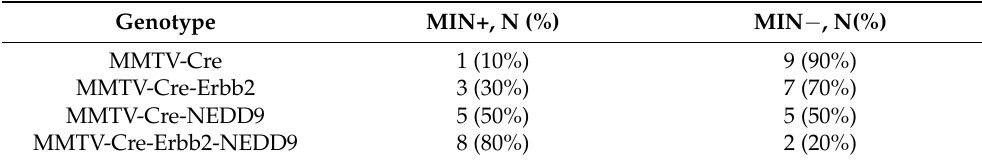
Figure 4. NEDD9 overexpression is associated with mammary intra-epithelia neoplasia. ( A ) Representative images of mouse mammary glands were stained with hematoxylin and eosin (H&E), genotypes as indicated in the figure. Scale bar — 20 mm; Insets — 200×. A total of 40 slides from 16-week-old nulliparous female mice with four genotypes were quantified. The average area per slide was 100–120 mm 2 . MIN was determined by lesions, characterized by glands, and lined by 1–2 layers of atypical epithelial cells with enlarged nuclei, clumped chromatin, variable nuclear size and shape, and an increased mitotic rate. ( B ) Quantification of mice with MIN per group (n = 10/genotype). White—no MIN detected, MIN+ positive (colored). Fisher’s exact test, p = 0.0137, number reported in Table 1. Table 1. Analysis of Mammary Intraepithelial Neoplasia (MIN) in